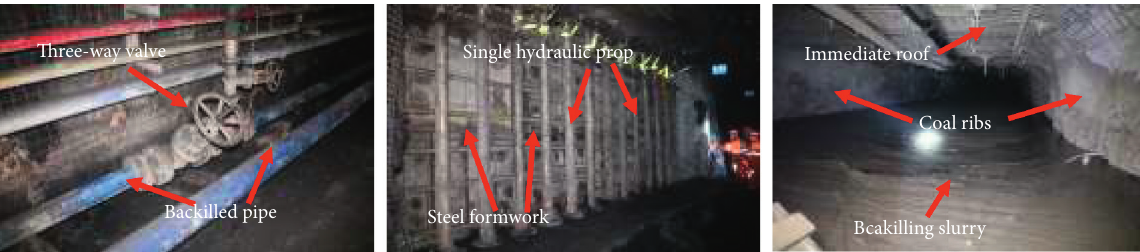
Figure 11: Photo of the backfilling effect.